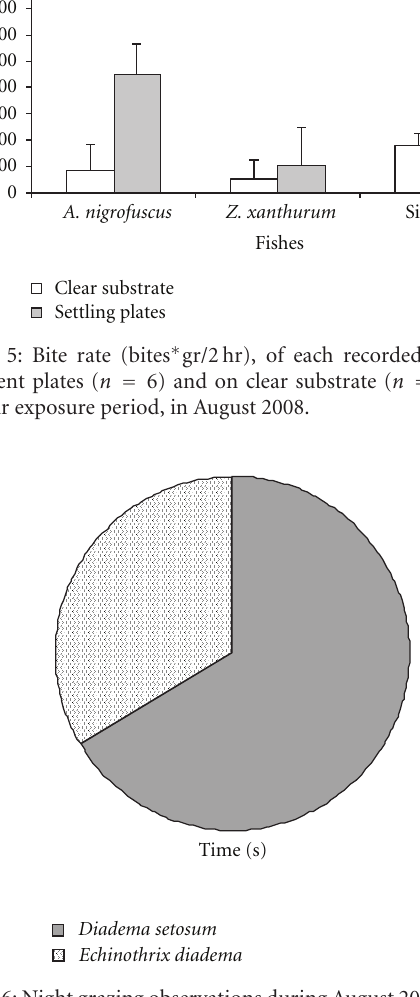
Figure 4: The number of bites normalized to fish weight, and the number of fish grazing on settlement plates. The number of bites normalized to fish weight, and the number of fish grazing on settlement plates exposed for 2 hours (T1), in February 2008. Black columns = bites ∗ gr ( n = 6), grey columns = number of fish ( n = 6).